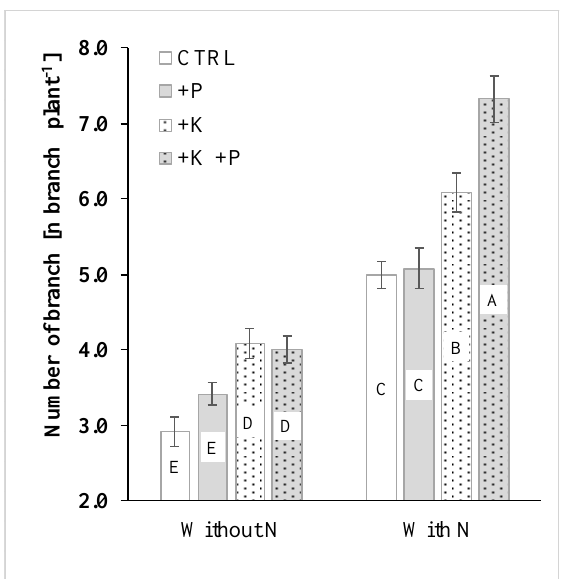
Figure 3. Least squares means (LSmeans) and standard error of the LSmeans of the number of branches per plant in Oenothera biennis L. local genotype (Evening Primrose) and Brassica napus